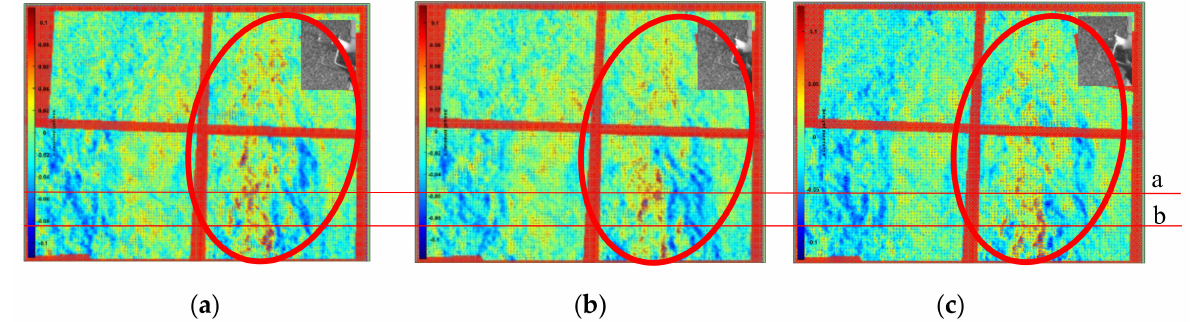
Figure 16. Frame skipping analysis diagram and horizontal baseline setting. ( a ) T = frame 570, ( b ) T = frame 595, ( c ) T = frame 620.